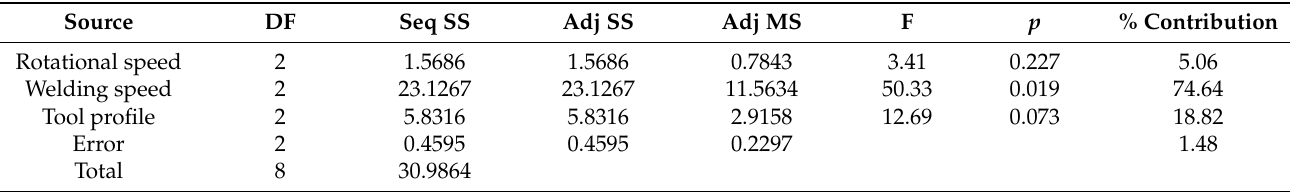
Table 9. Analysis of variance for the signal-to-noise ratios for tensile